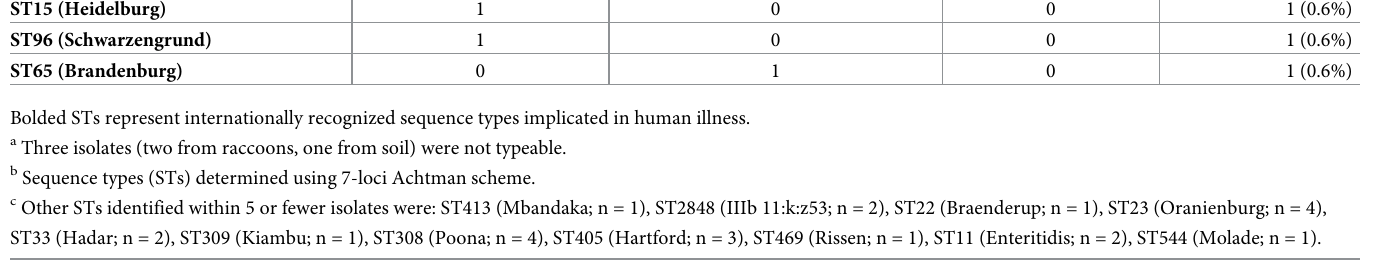
ST404 (Paratyphi B var. Java)